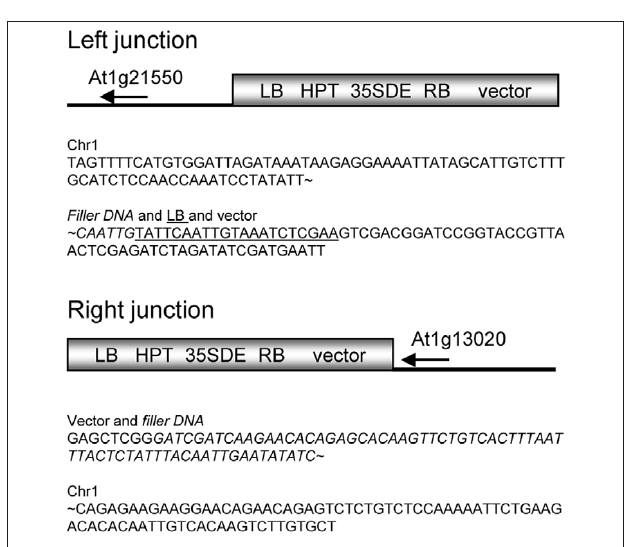
FIgURe 2 | genetic characterization of the sns-D mutant. Schematic representation and sequences of the left and right junctions of the T-DNA and binary vector insert in chromosome 1 of the sns-D mutant. Sequence of filler DNA is italicized and sequence of LB is underlined. LB, left T-DNA border repeat; RB, right T-DNA border repeat; HPT, hygromycin phosphotransferase gene; p35SDE, 35S CaMV promoter with double enhancer.